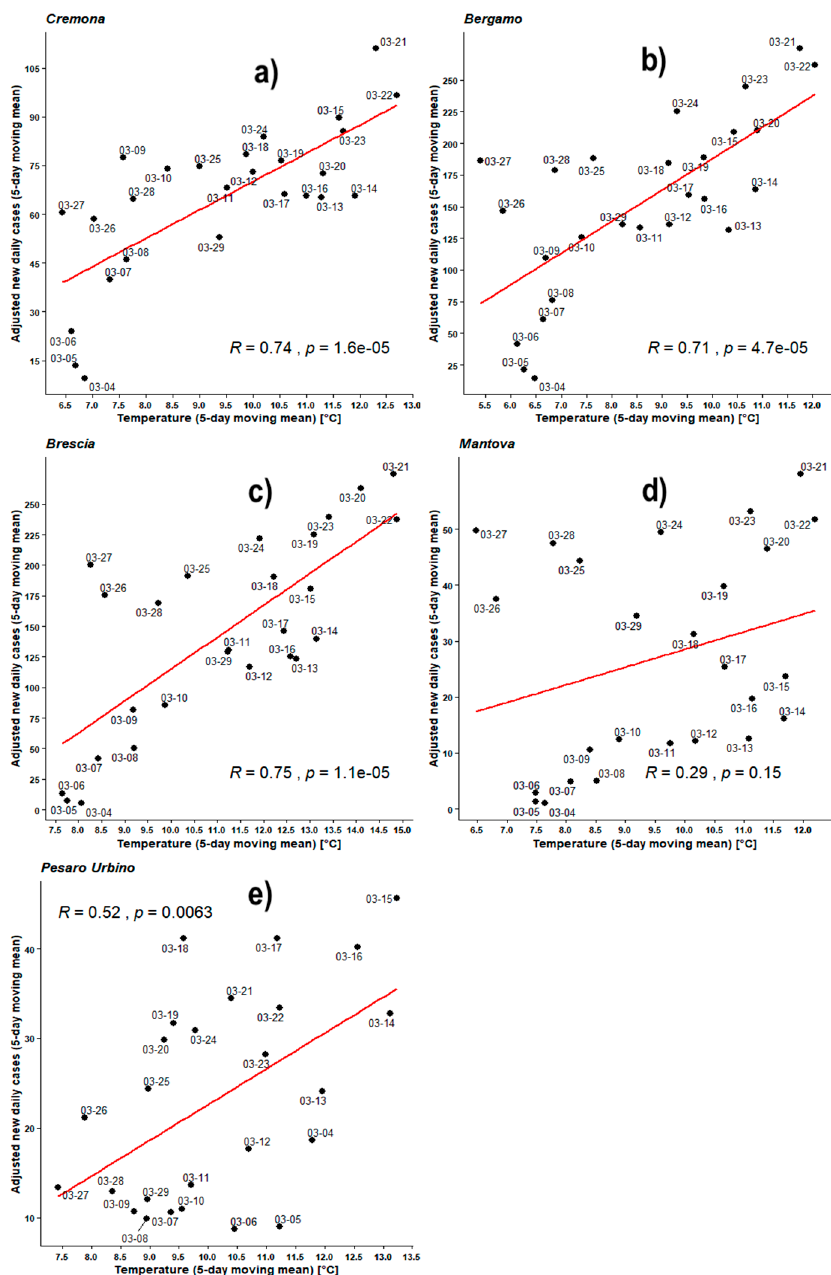
Figure 5. Scatter plot and linear regression for the 5-day moving means of adjusted new daily cases of COVID-19 against outdoor temperatures for five Italian provinces: ( a ) Cremona, ( b ) Bergamo, ( c ) Brescia, ( d ) Mantova, ( e ) Pesaro Urbino. Labels report, in MM-DD format, the last day of the moving means. Pearson correlation coe ffi cient is reported as ‘R’ while probability value is reported as ‘ p